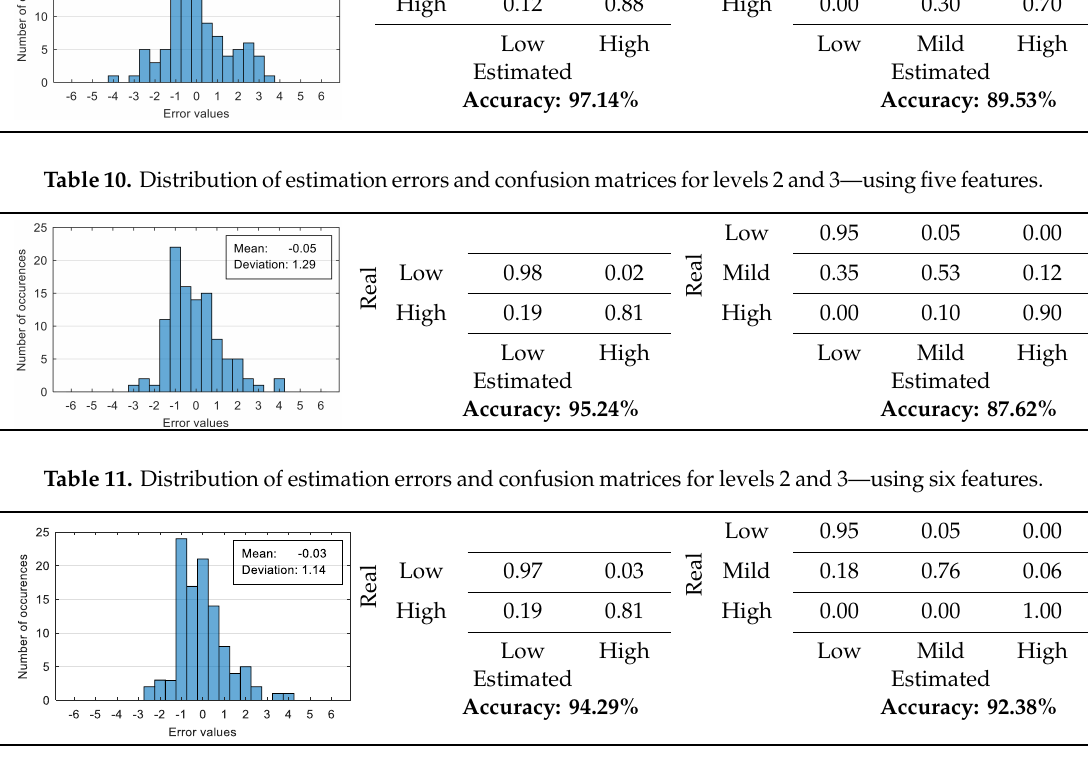
Table 12. Distribution of estimation errors and confusion matrices for levels 2 and 3 — using seven